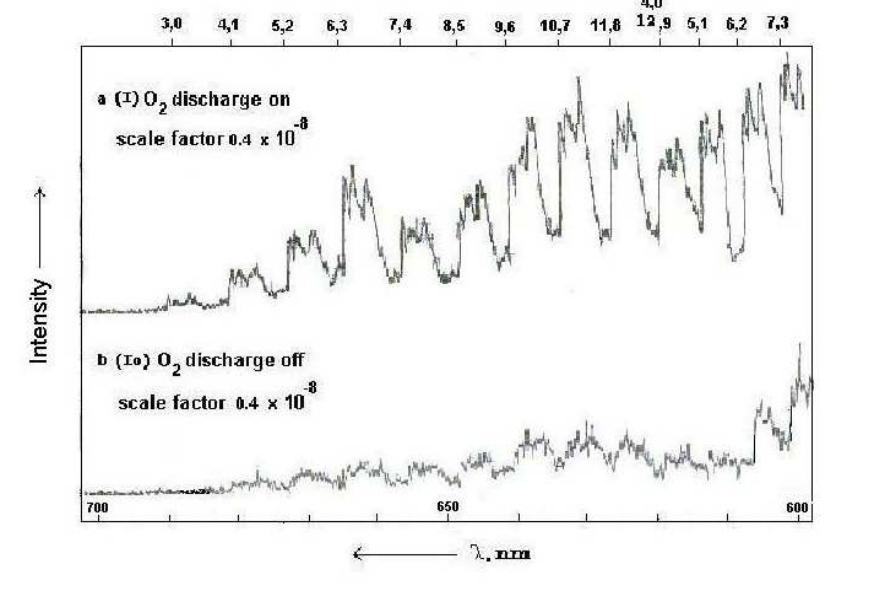
Fig. 4 N 2 (B 3 Π g → A 3 Σ + ) emission spectra showing parts of the ∆ υ = 3 and 4 band sequences u of the first positive band system (1pbs) , with and without discharged O 2 . The vibrational levels of each band in a 1pbs { N 2 (B 3 Πg → A 3 Σu + ) } sequence are shown over each band with the N 2 (B 3 Πg) vibrational level of each band shown first. Active nitrogen was produced by mw discharging a mixture of A r and N 2 . P N = 1.4 mbar, P A = 0.3 mbar and P O = 0.2 mbar. 2 2 r The spectra are not corrected for grating and detector nonuniform spectral